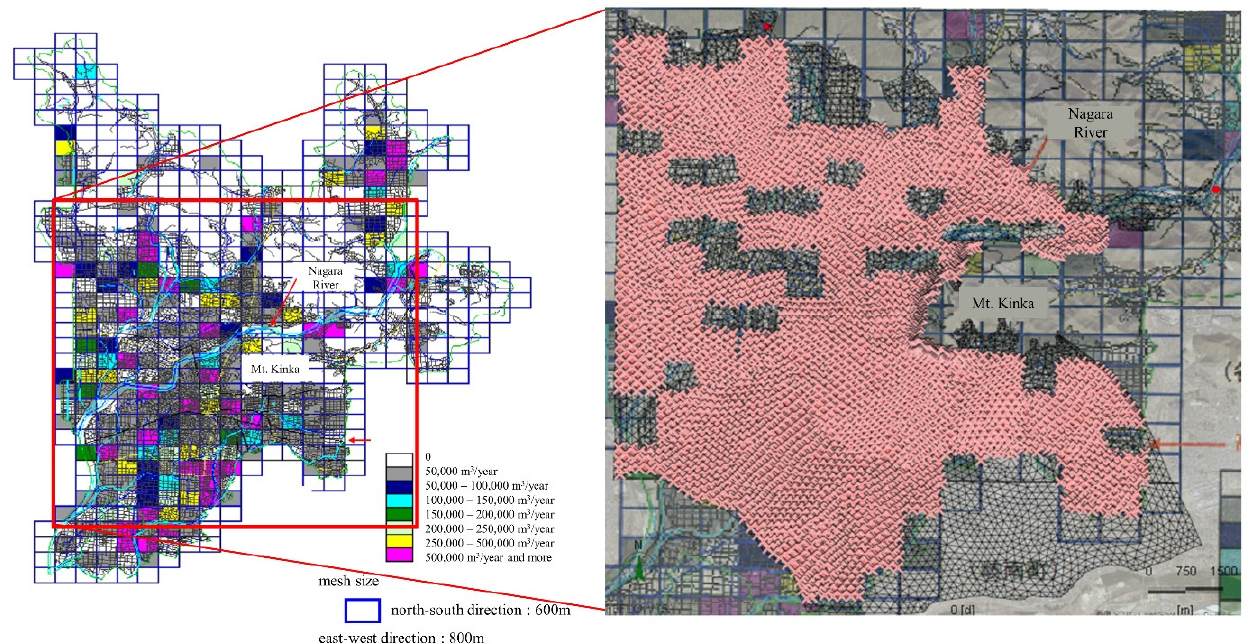
Figure 5. ( Left ) Reported pumping rate in each mesh of Gifu City (Adapted from Gifu Prefecture, Gifu City, Teikoku Construction Consultant (2011), Report on feasibility study of geothermal heat pumps, 201p. [14]). ( Right ) Setting of pumping-rate boundary condition.